Question: Sum up the contents of this chart in one sentence.
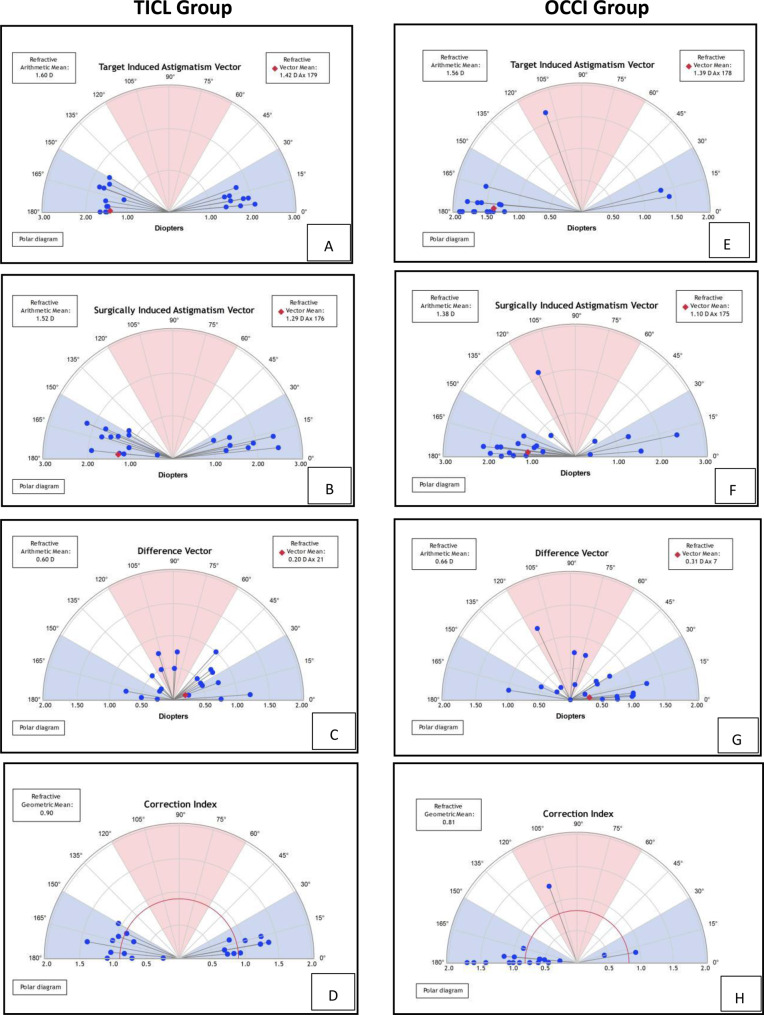
Answer: Single‑angle polar plots of vector parameters for the TICL and OCCI groups at 6 months postoperatively. ( A – D ) TICL group: ( A ) target‑induced astigmatism (TIA), ( B ) surgically induced astigmatism (SIA), ( C ) difference vector (DV), ( D ) correction index (CI). ( E – H ) OCCI group: ( E ) TIA, ( F ) SIA, ( G ) DV, ( H ) CI. Vector means are plotted as red diamonds